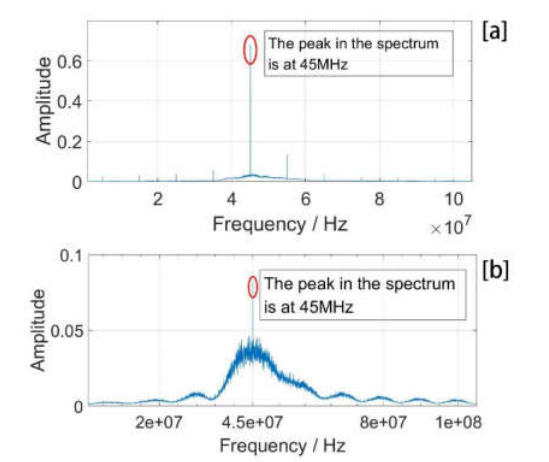
Figure 3 The final signal spectrum for the range of